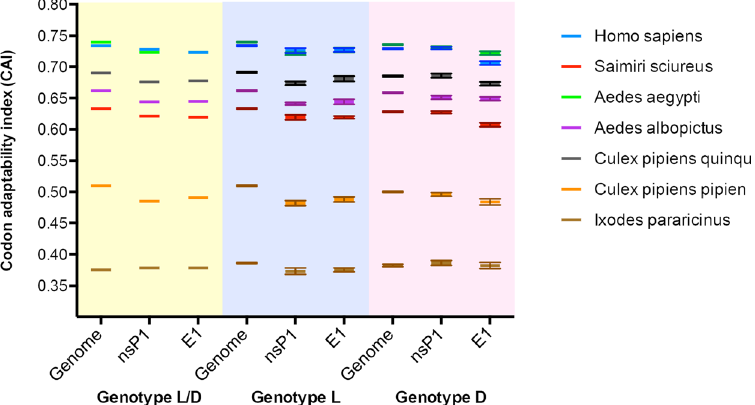
Figure 4. Codon adaptability index (CAI) analysis for MAYV full-genome and gene sequences based on the codon usage of the most frequent genes of various host and vector species. CAI values based on full-genome, and nsP1 and E1 genes, reflecting the adaptation of MAYV genotypes L/D (yellow shade), L (blu shade), and D (pink shade) to human and non-primate hosts, and arthropod vectors. Values are reported as mean ± standard deviation, with the exception genotype L/D, for which only two sequences are